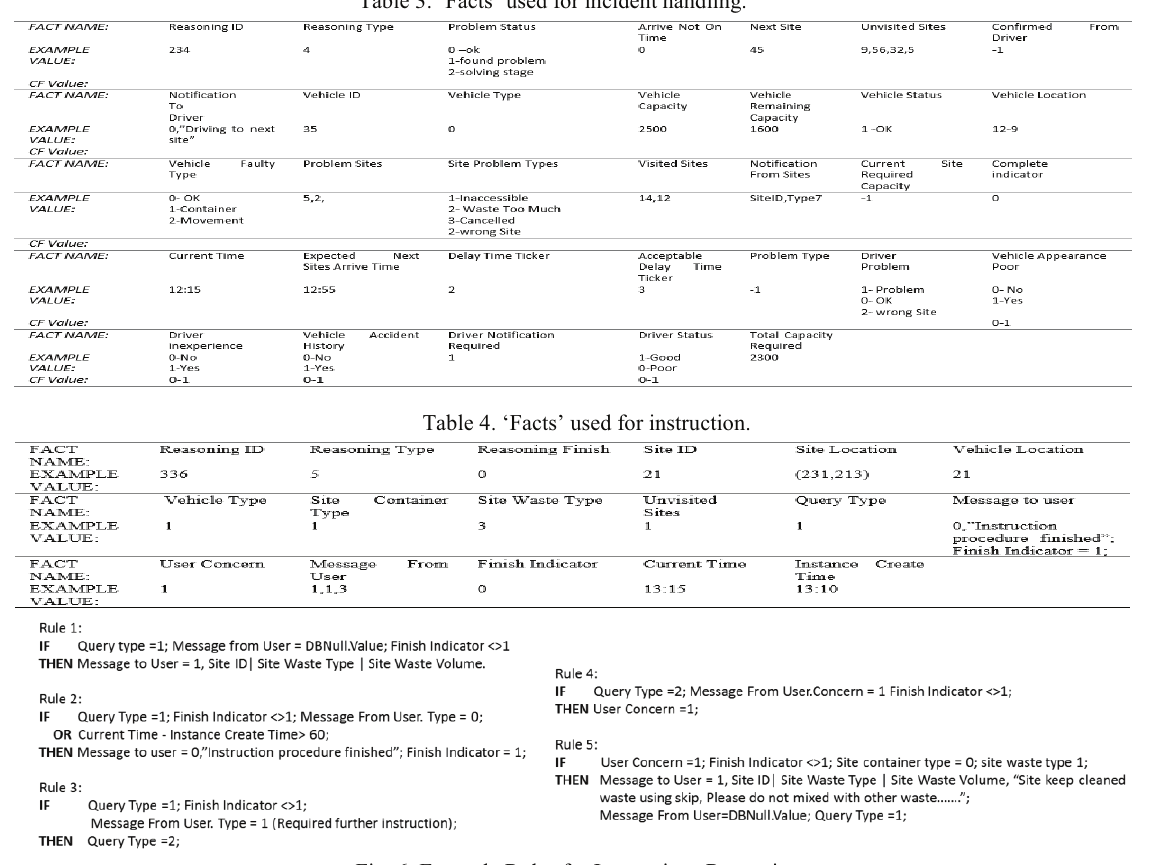
Fig. 6. Example Rules for Instructions